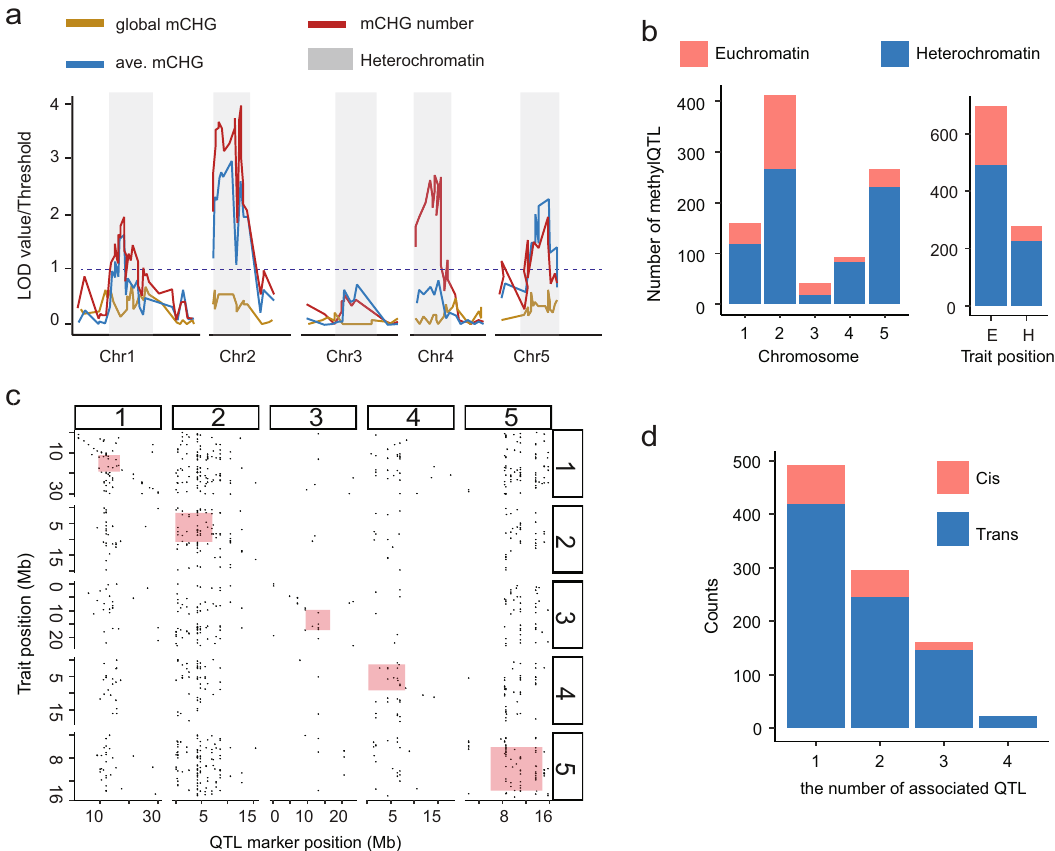
Fig. 4 Methylation QTL for genes with ectopic mCHG are especially enriched in the pericentromeric regions. a Standard interval QTL mapping for genic mCHG related phenotypes. Methylation status (methylated, unmethylated) on 144 stably inherited DMR makers was used for QTL mapping. The results for three phenotypes, global mCHG level (global mCHG), the number of mCHG-gain genes (mCHG #), averaged mCHG level on genes (ave. mCHG), were plotted as likelihood-ratio test statistic (LOD score divided by threshold value of 3) against physical location of markers (Mb). b Barplots shows that methylQTL are especially enriched in the pericentromeric regions in comparison to euchromatin, whereas affected genes are enriched in euchromatin (right bar plot). E = Euchromatin and H = Heterochromatin. c The scatter plot shows the location of the 701 genes against the location of their corresponding methylQTL, respectively. d A comprehensive QTL analysis for each of the1595 genes that had evidence of ectoipc mCHG. Signi fi cantly associated QTL loci were identi fi ed for 701 genes. For association detected, half of them were linked with a single methylQTL, and others were found to be associated with 2 – 4 methylQTL. The majority of methylQTL are distant (trans) to associated genes. Source data underlying Fig. 4b – d are provided as a Source Data fi